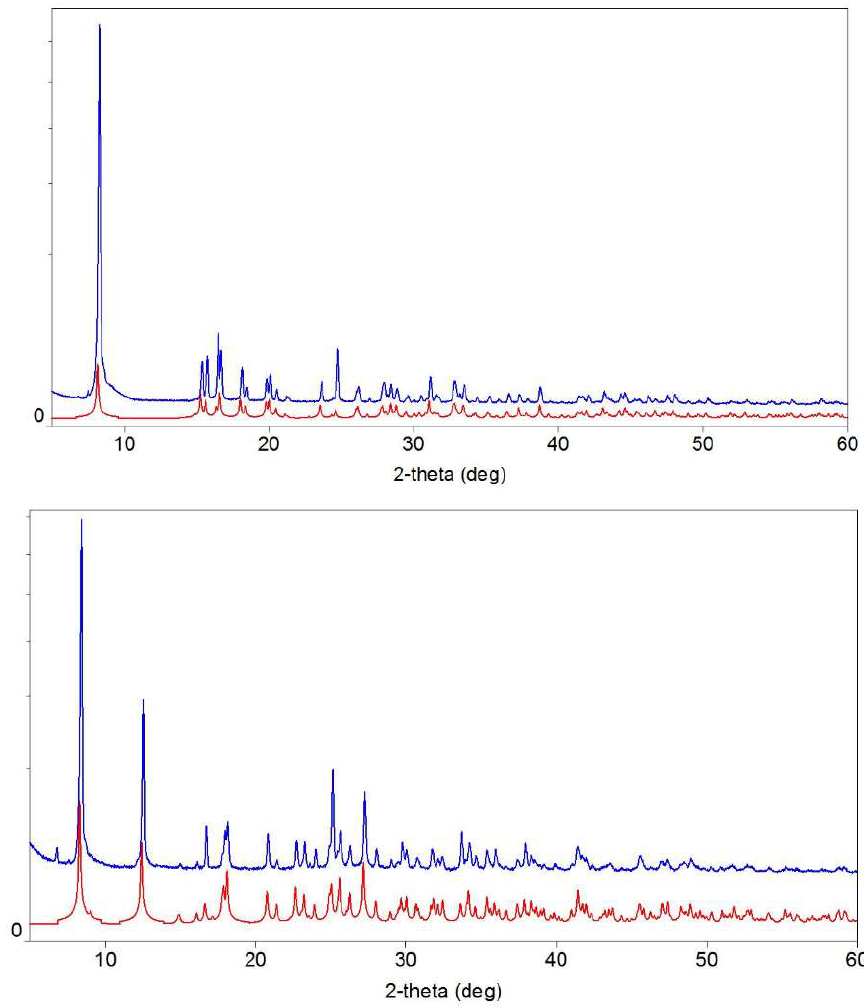
Figure 1. Comparison of powder diffraction pattern for synthesized samples (blue) with those calculated from single crystal X-ray data for disodium (CCDC number 1216797) and dipotassium (CCDC number 1200201) phthalatocuprates (red): top —compound I , bottom —compound II .